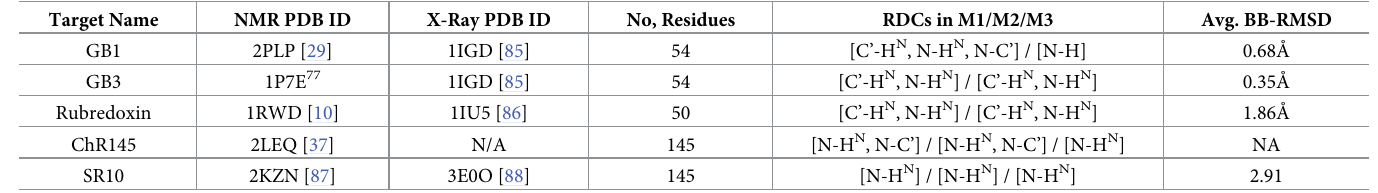
Table 4. List of protein targets with their respective X-ray and NMR reference structures, RDCs used and the average BB-RMSD between the NMR and X-ray